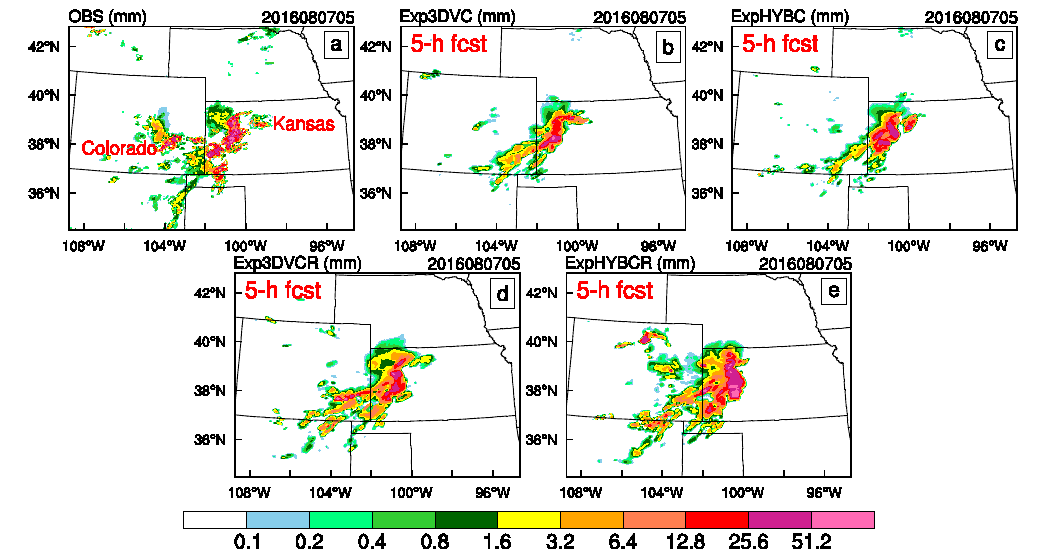
Figure 7. One-hour accumulated precipitation (unit: mm) of: observation ( a ); Exp3DVC ( b ); ExpHYBC ( c ); Exp3DVCR ( d ); and ExpHYBCR ( e ) of the convective system at 05:00 UTC on 7 August 2016 (initialized at 00:00 UTC on 7 August 2016).